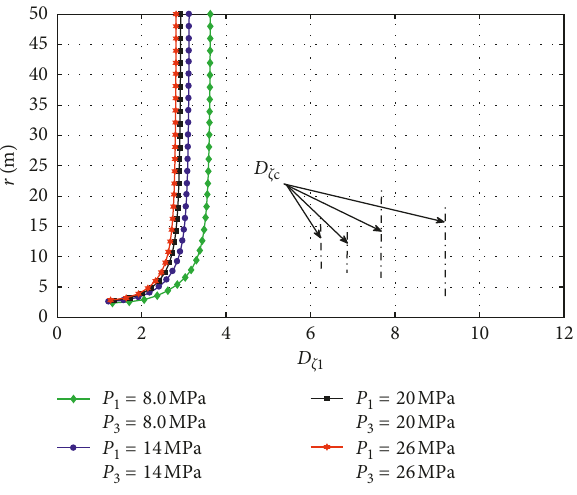
Figure 7: Relation curves of r - D